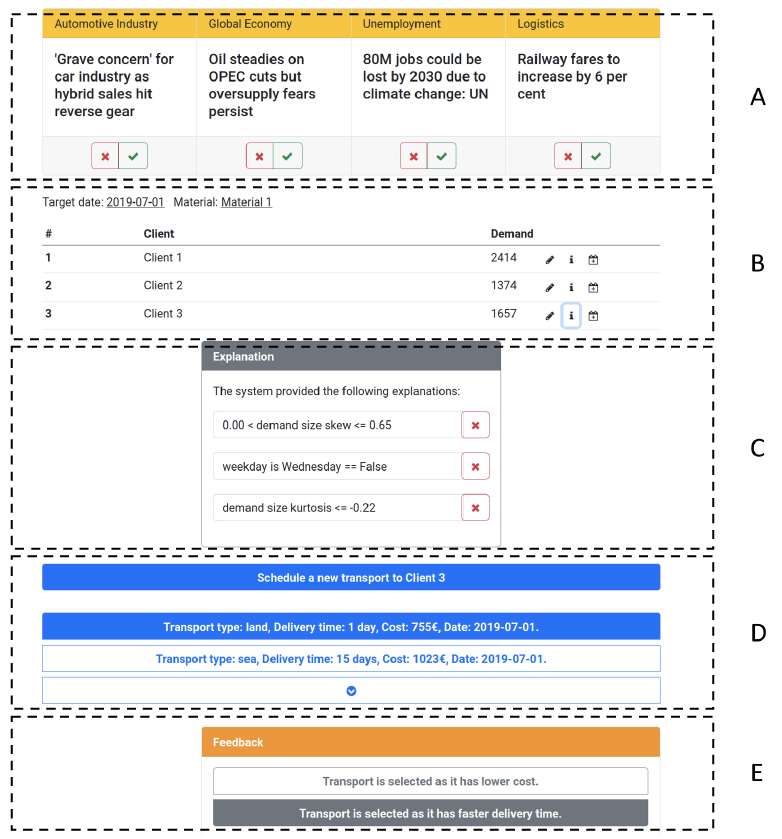
Figure 2. User interface, displaying contextual media news, forecasts, forecast explanations, and recommended decision-making